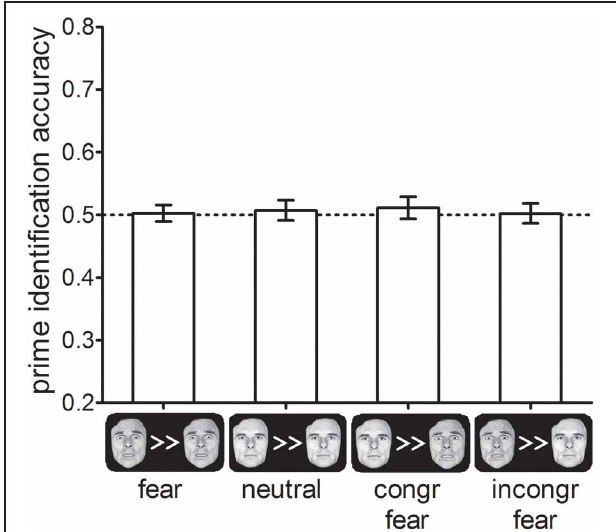
FIGURE 5 | Percentage correctly identified primes as a function of cue-types in Experiment 3. Error-bars indicate standard errors of the